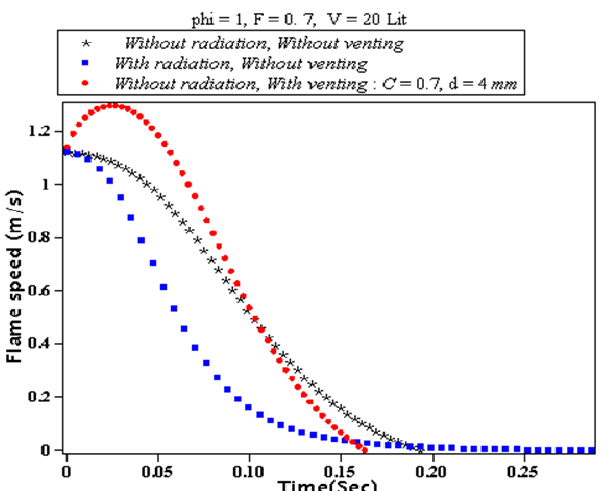
Fig. 10. Effect of radiation heat loss and venting on flame